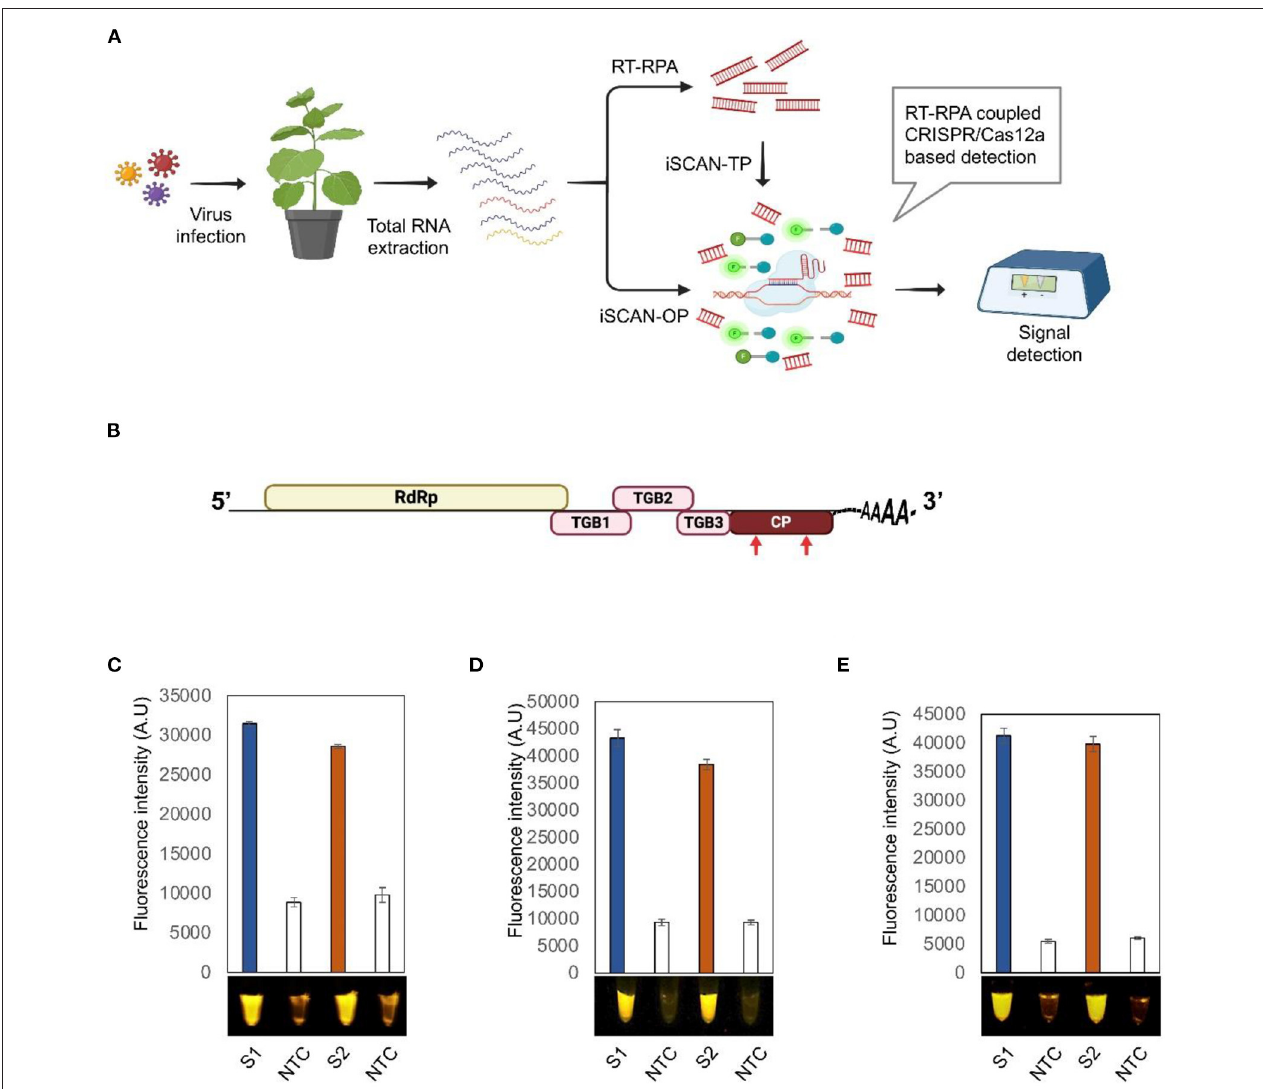
FIGURE 1 | Detection of potato virus X (PVX) by RT-RPA-CRISPR/Cas12a. (A) Workflow of the RT-RPA coupled CRISPR/cas12a-based detection system. (B) Schematic diagram of PVX genome. Red arrows indicate the regions targeted by the RT-RPA CRISPR/Cas12a-based detection system. (C–E) End point fluorescence visualization of the iSCAN-TP (two pots) (C) or IScan-OP (one pot) (D,E) detection assay of in vitro transcribed RNA of PVX-CP (C,D) or total RNA isolated from Nicotiana benthamiana plants infected with PVX (E) . S1, RPA primer set 1; S2, RPA primer set 2; NTC, no template control. Values are shown in the graph as means ± SD ( n =